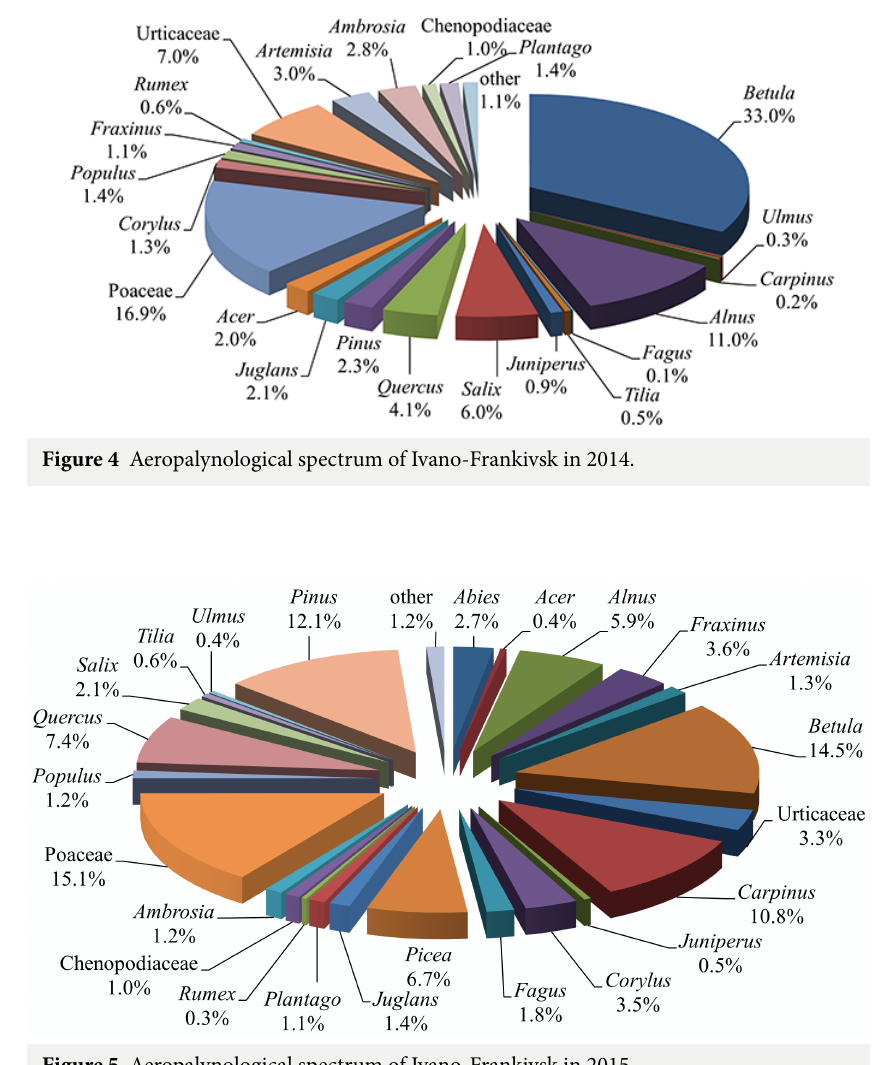
Figure 5 Aeropalynological spectrum of Ivano-Frankivsk in